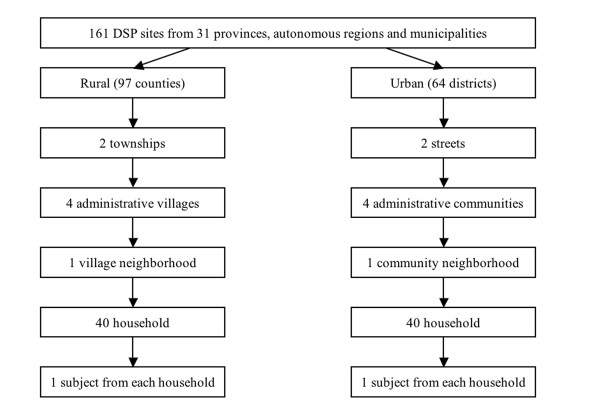
Flow chart of multi-stage sampling procedure of China Chronic Disease Risk Factor Surveillance 2007.